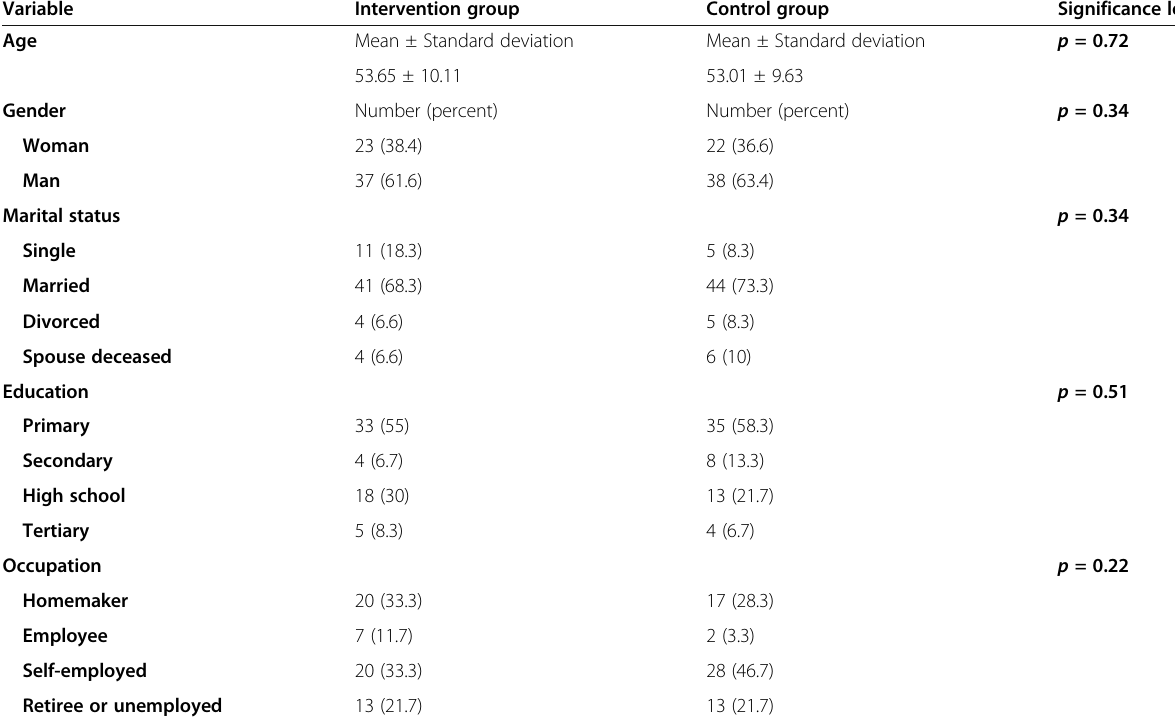
Table 1 Demographic characteristics of patients in the intervention and control groups (Patients discharged from the 22nd Bahman Hospital of Khaf in 6 months since 2020)